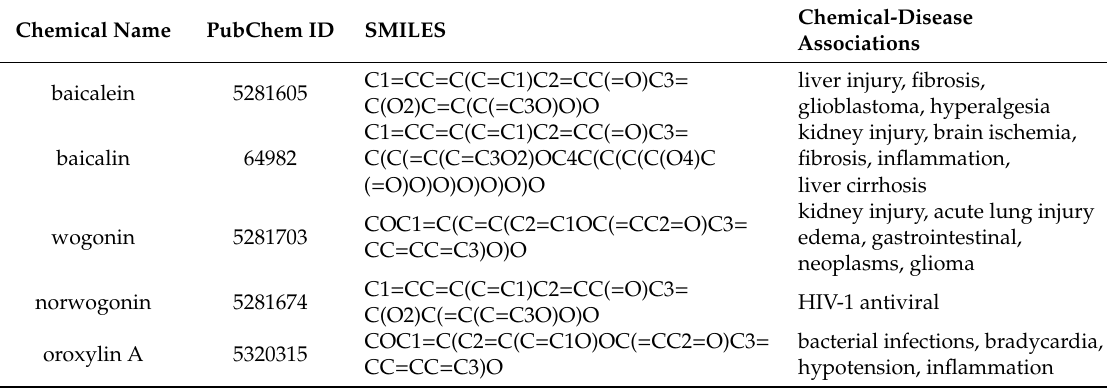
Table 2. Chemical name, PubChem ID, SMILES files, and chemical–disease